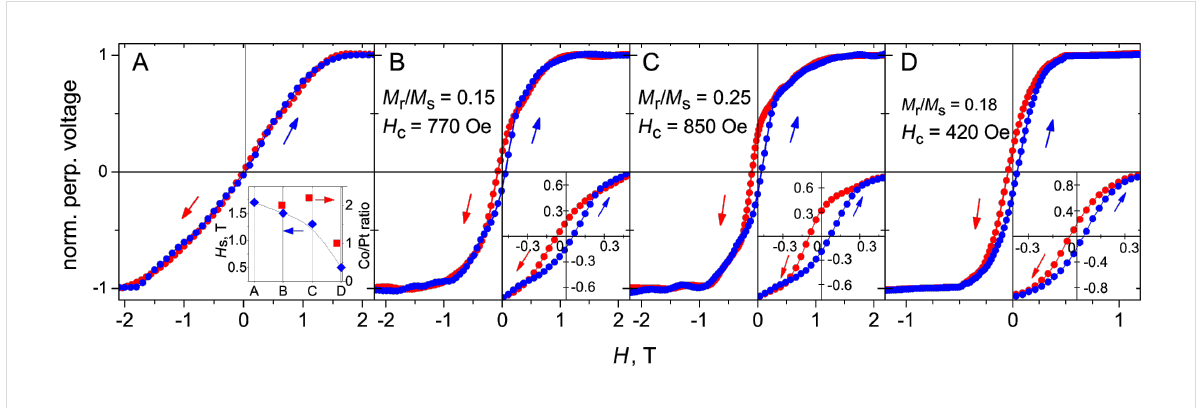
Figure 4: Hall voltage cycling at 10 K for all samples. Before measurements, all samples were saturated at 3 T. Note the different field range and scale for sample D. Inset in A: The magnetization saturation fields H s and the Co/Pt ratios for all